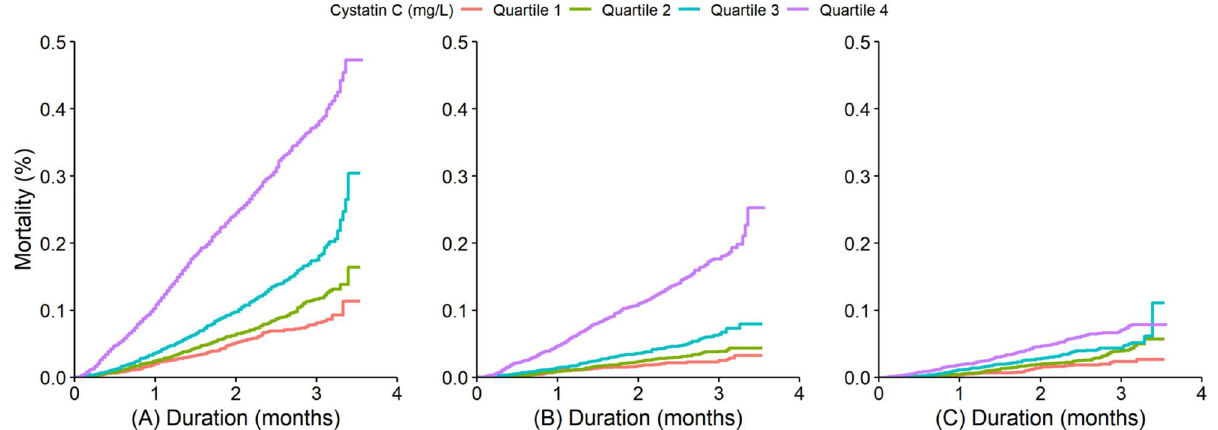
Figure 1. Kaplan–Meier curves for all-cause, cardiovascular and cancer mortality stratified by baseline cystatin C concentration quartiles. ( A ) Kaplan–Meier curves of all-cause mortality; ( B ) Kaplan–Meier curves of cardiovascular mortality; ( C ) Kaplan–Meier curves of cancer mortality. quartile 1 (Q1, < 0.84 mg/L), quartile 2 (Q2, 0.84–0.97 mg/L), quartile 3 (Q3, 0.98–1.20 mg/L), and quartile 4 (Q4, > 1.20 mg/L).